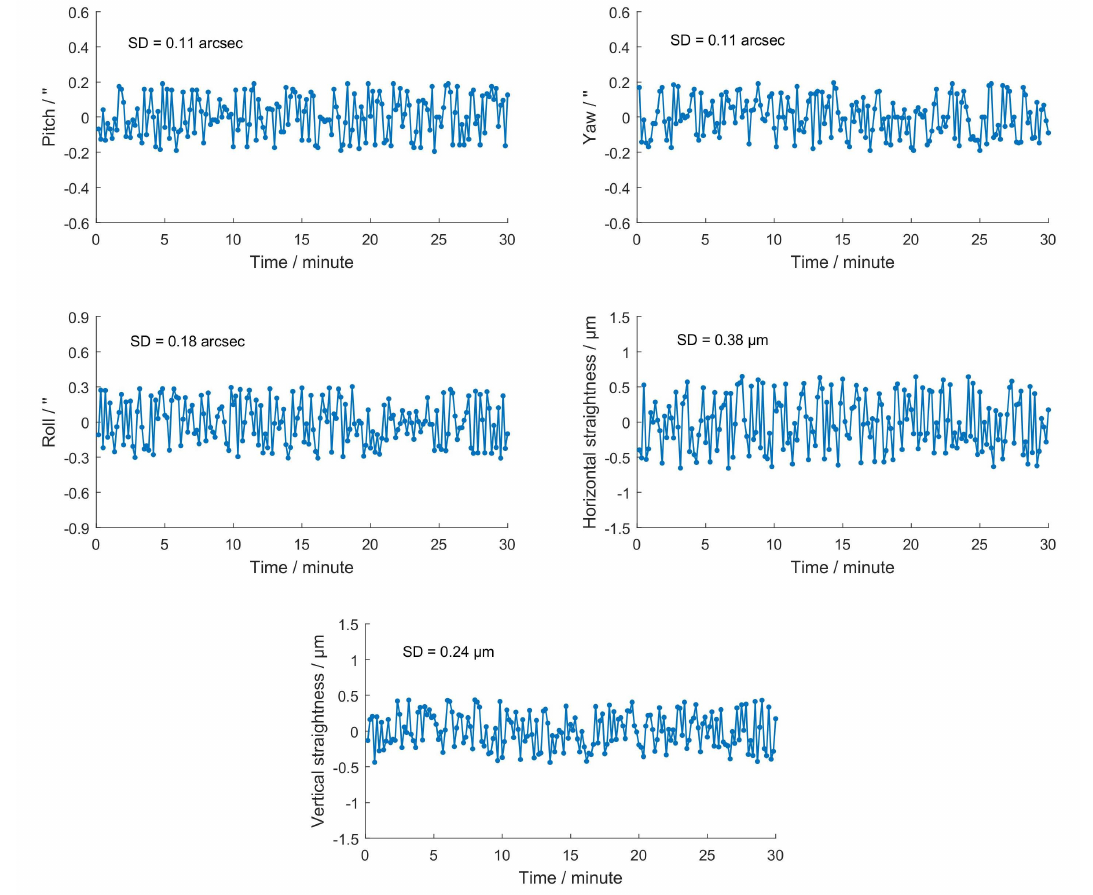
Figure 10. Results of the stability